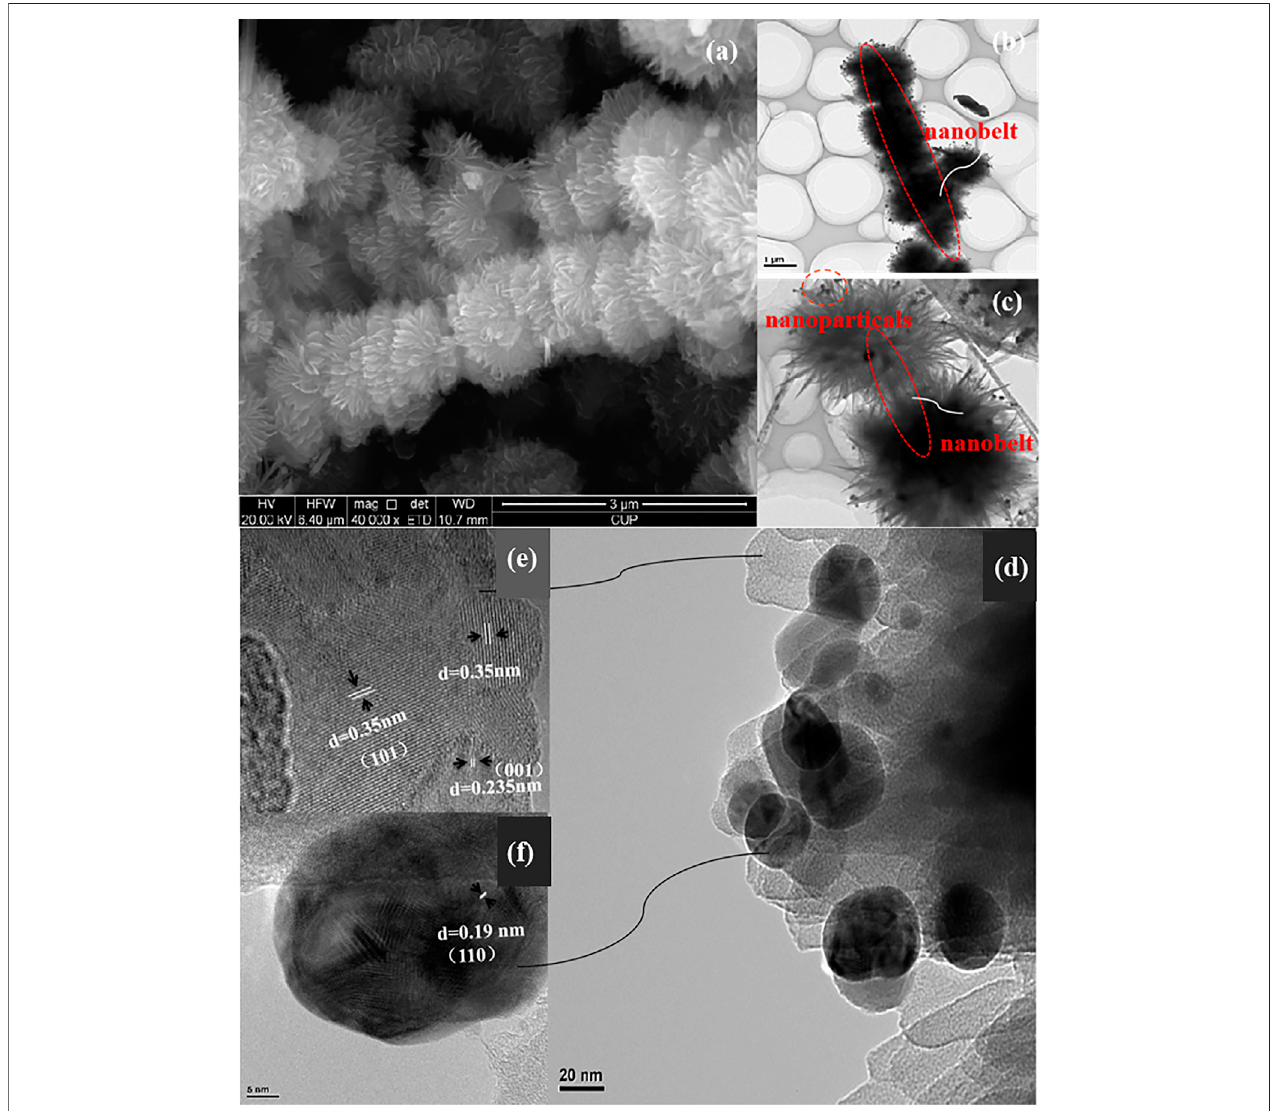
FIGURE 1 | Magni fi cation (A) SEM, TEM (B) and HRTEM (C) of the prepared HSN; HRTEM of the prepared HSN; (D) : the lattice spacing parallel of thenanosheet (E) and the nanoparticals (F) in HSN.